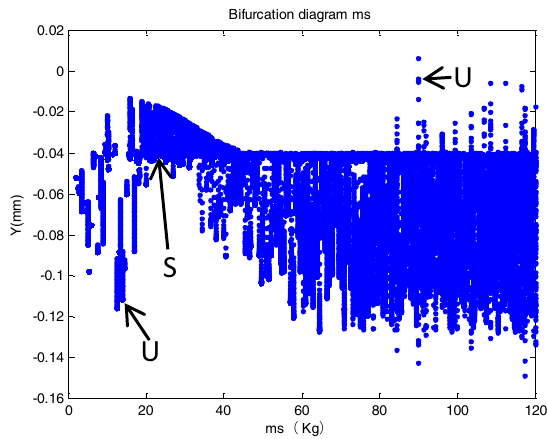
Fig. 13 Bifurcation diagram of the dynamic response Y vs.mass of the rotor ms; S means the relatively stable region; U means the rela- tively unstable